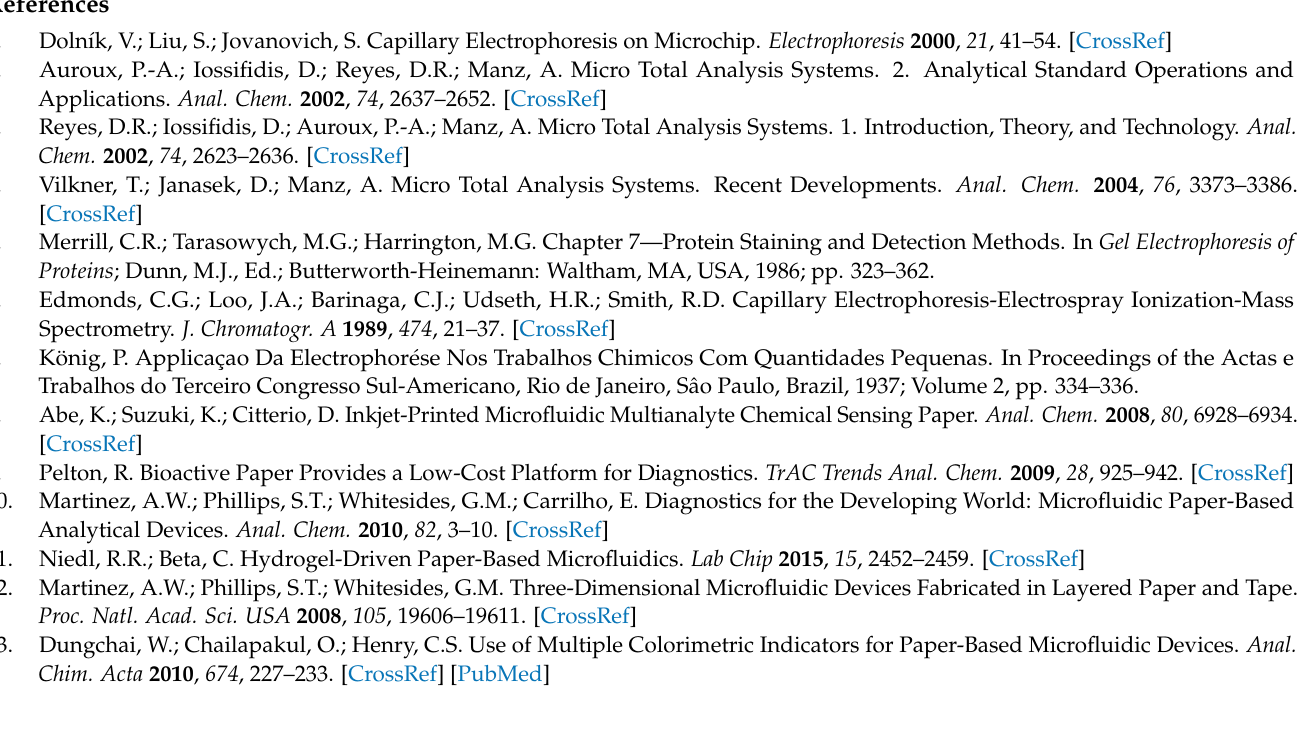
Figure S2: Digital microscopic image showing a section of the chip geometry before and after the transfer to the glass microfiber. Figure S3: Measurement setup of a prototype for future read-out. Figure S4: Microscopic determination of the layer thickness of a carbon paste electrode. Figure S5: Post-staining of single fragment by intercalating dye GelRed after completing fiber elec- trophoresis. Figure S6: Duplicate measurement of DNA samples eluted after fiber-electrophoresis and used as a template for PCR and real-time PCR. Figure S7: Signals of the positive control with 100 ng 910 bp fragment before fiber-electrophoresis (blue) and a negative control with no tem- plate after real-time PCR with SyGreen (orange). Figure S8: HRP detection via TMB addition and verification of migrated DNA through the fiber by staining with GelRed and elution from the same chip. Figure S9: Detection of remaining proteins after fiber-electrophoresis of a Legionella cell lysate. Video S1: Wetting of the glass microfiber chip. Video S2. TMB oxidation by HRP after fiber